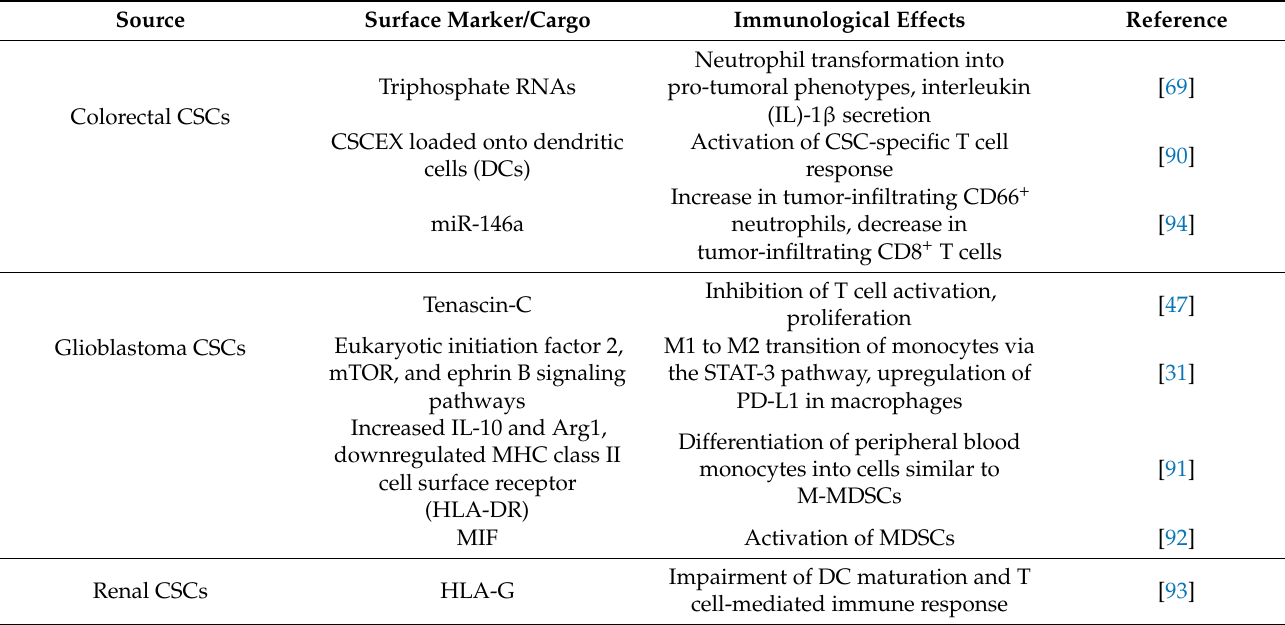
Table 2. Immunological properties of cancer stem cell-derived exosomes